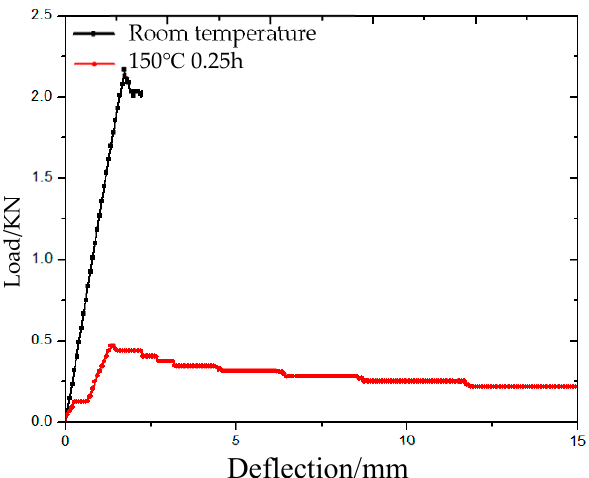
Figure 4. Deflection–load curves of 3Dim–5Dir braided composites at room temperature and 150 °C.